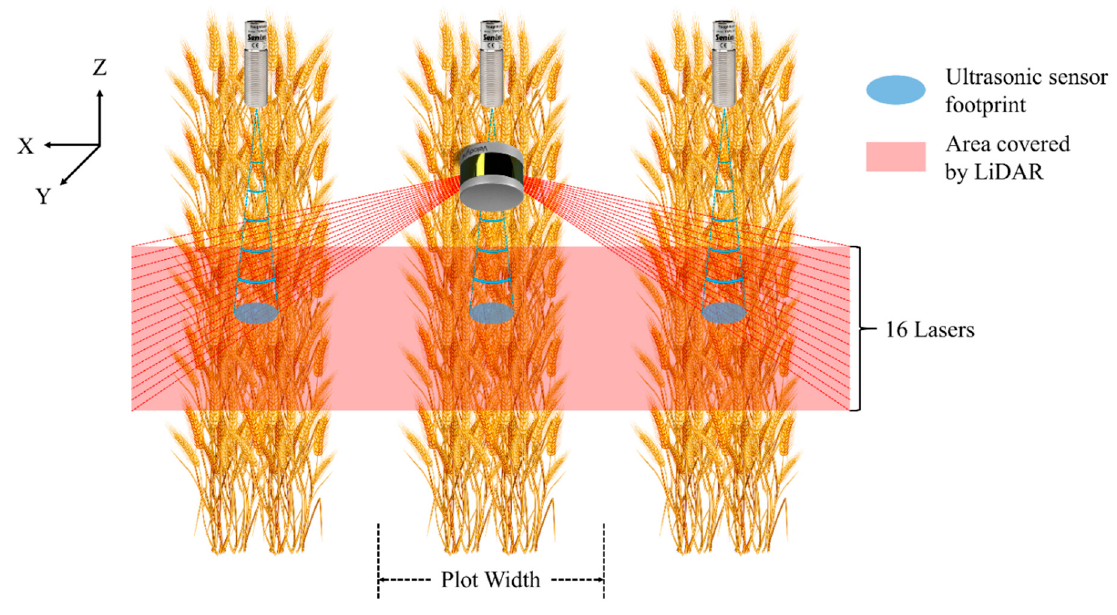
Figure 2. Schematic diagram showing the scanning areas of LiDAR and ultrasonic sensors at each measurement.